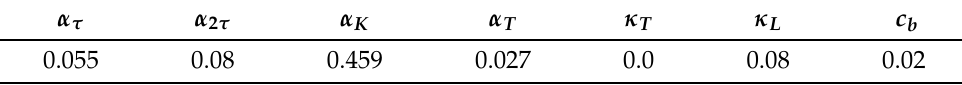
Table 3. Parameters for Regulatory Constraints (20) and